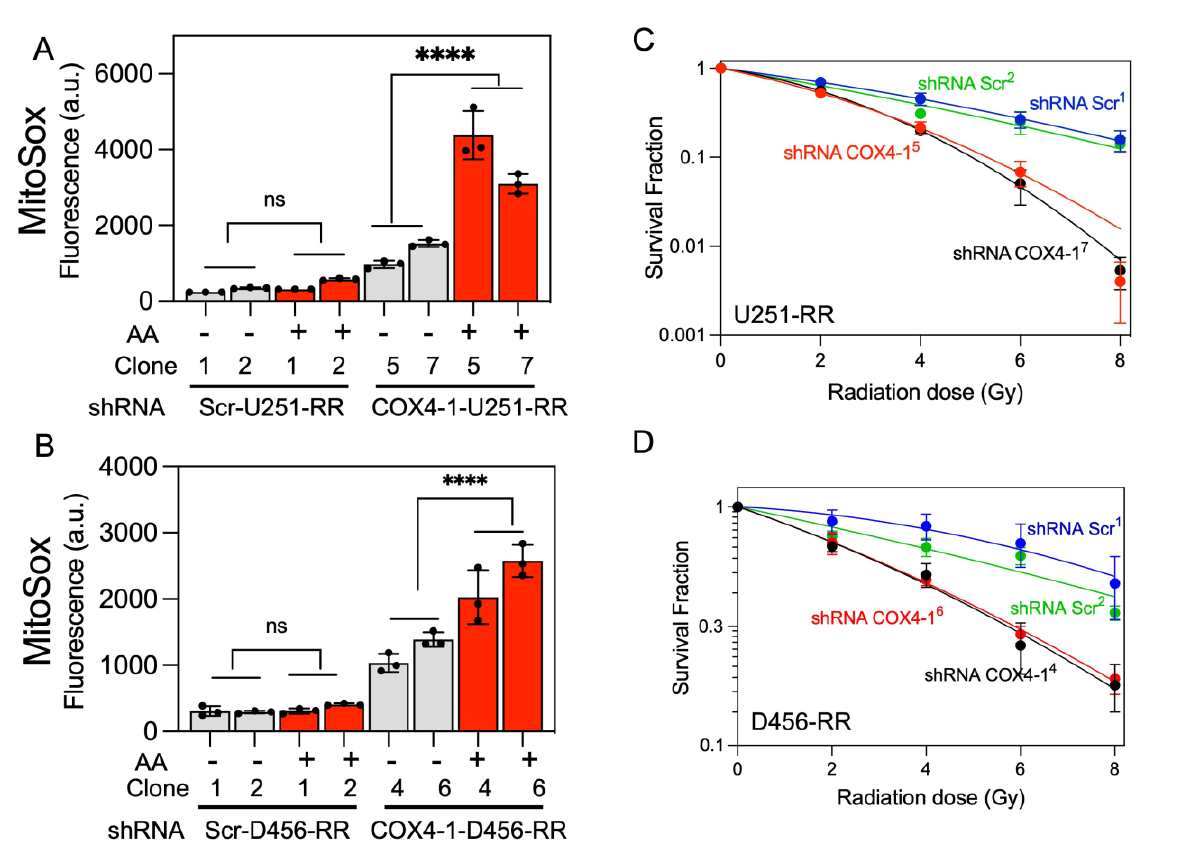
FIGURE 8: Silencing COX4-1 increases O 2 ● - production in GBM cells with acquired radioresistance. (A) Quantification of mitochondrial O 2 ● - production in U251-RR (top) and D456-RR (bottom) cells transfected with shRNA targeting COX4-1 or scramble shRNA and treated with or without AA (10 μM for 15 min), assessed by MitoSOX assay. Data are presented as the mean ± SEM (n=3). (B) Clonogenic survival curves for U251-RR (top) and D456-RR (bottom) cells transfected with shRNA targeting COX4-1 or scramble shRNA. Cells were irradiated (0 – 8 Gy) and immediately plated. Clonogenic survival was estimated on day 14 after irradiation. ***p<0.001, calculated using one-way ANOVA followed by Tukey’s multiple comparison test. p < 0.0001 (****), calculated by Student t -test. a.u., arbitrary units; AA, antimycin A; ns, not signifi-